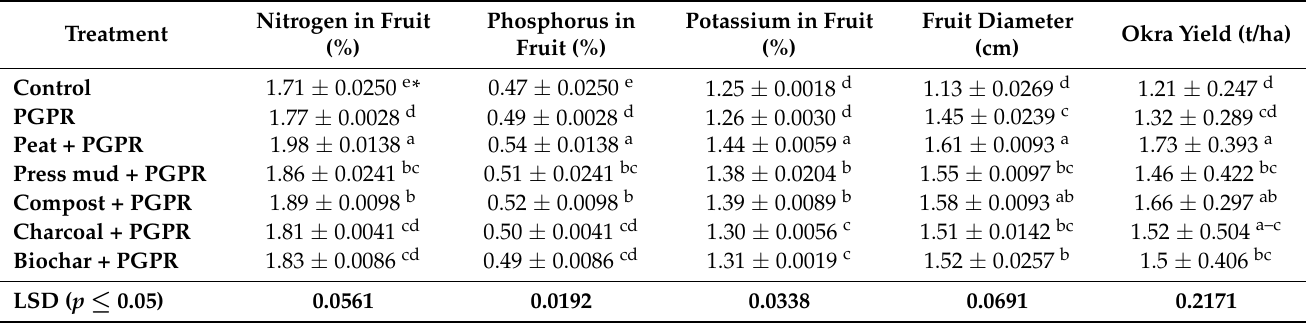
Table 7. Effect of different carrier materials on yield parameters of okra in the field trial. Values are mean ± standard error of three